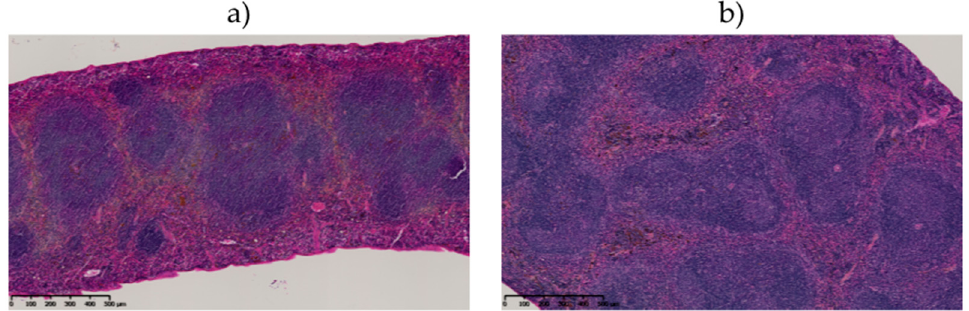
Figure 7. Spleen histology of control and 211 At-9E7.4 injected mice. Comparison between spleen of control rodent ( a ) and of mice 160 days after injection of 740 kBq of 211 At-9E7.4 ( b ) showing lymphoid follicular hyperplasia in this latter. Hematoxylin-Phloxin-Saffron.